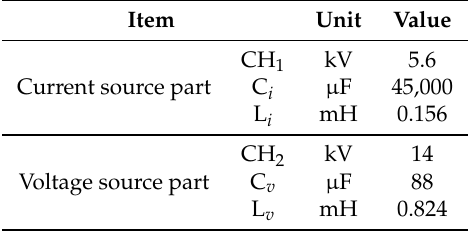
Table 3. Parameter values of current and voltage source parts.